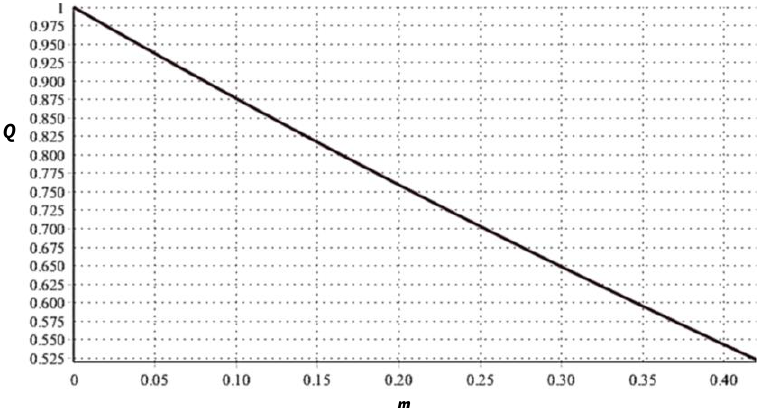
Figure 11. Percentage of power processed by the flyback Q vs Gain m .